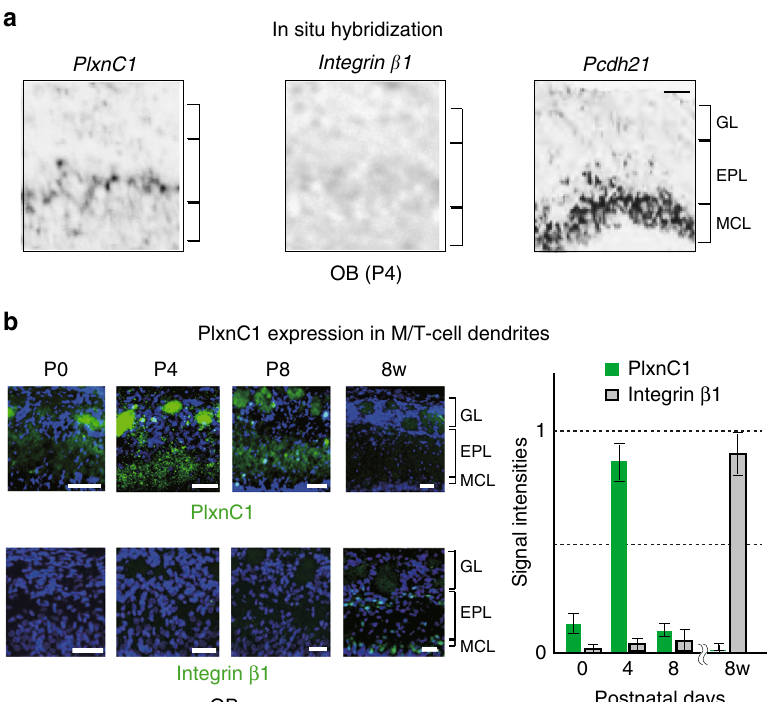
Fig. 2 PlxnC1 localized to the M/T-cell dendrites as Sema7A receptor in neonates. a Expression of candidate receptors for Sema7A in the OB. OB sections at P4 were analyzed by in situ hybridization using the probes for PlxnC1 , Integrin β 1 , and Pcdh21 (M/T-cell marker). n = 6 animals. Scale bar = 30 μ m. b Temporal regulation of PlxnC1 expression in the OB. OB sections were immunostained with antibodies against PlxnC1 and Integrin β 1 at various developmental stages. Relative signal intensities (GL/EPL) are compared at different time points. n = 2 animals except for P4 ( n = 6). Scale bars = 30 μ m. GL glomerular layer, EPL external plexiform layer, MCL mitral cell layer